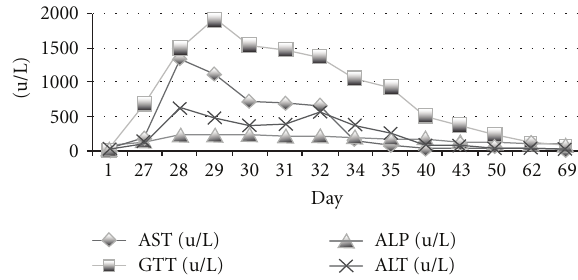
Figure 1: Liver enzymes show an acute rise on day 27, with gradual normalization by day 69 (42 days after the initial